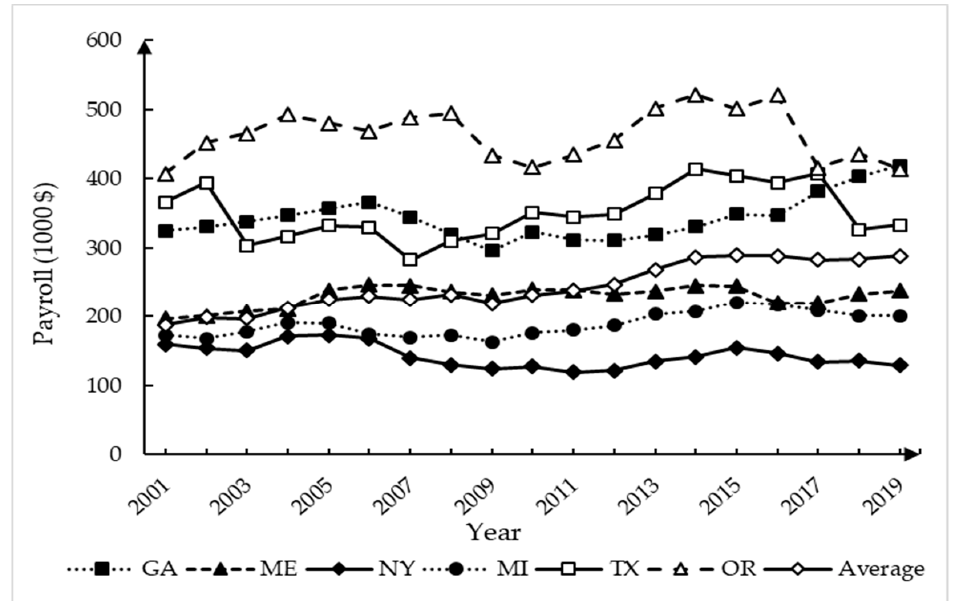
Figure 8. Inflation-adjusted payroll per logging firms (2019 Constant-dollar) in some states, 2001 to 2019 [38,41]. Notes: GA, ME, NY, MI, TX, and OR signify Georgia, Maine, New York, Michigan, Texas, and Oregon, respectively.